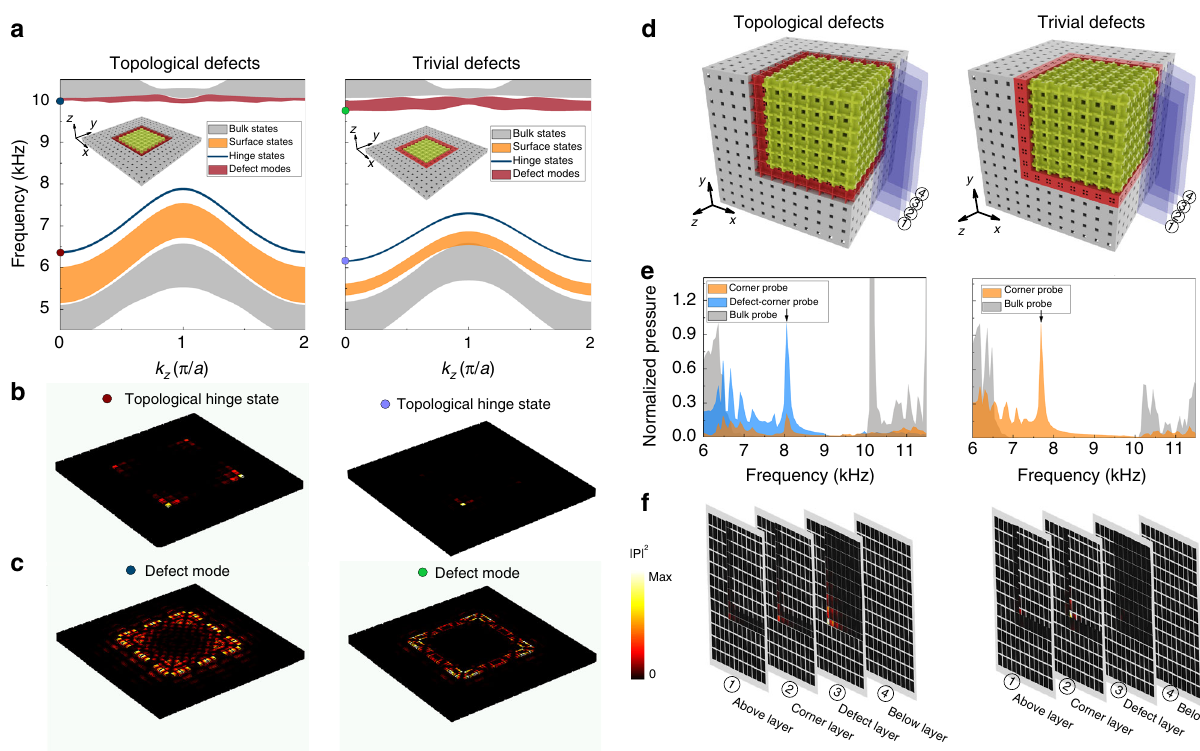
Fig. 6 Topological hinge and corner states with the existence of symmetry-preserving defects. Two types of defects as that in Fig. 5 are studied. a – c The same as that presented in Fig. 5, but for the hinge supercell consisting of a topological SC with 7 ´ 7 unit cells, surrounded by a wall of trivial SC with four unit cells. The defect layer is inserted at the interfaces between the topological and trivial SCs (see the insets in a for the detailed structures). It is observed from the fi gures that the symmetry-preserving defects do not considerably affect the topological hinge states, which emerge and remain in the gaps of the surface and bulk states. d Structures with a defect layer made of topological or trivial SC and inserted on the interfaces of the corner supercell. e Numerically calculated transmission spectra for both the corner and bulk probes under a point source excitation (near the concerned corner). Transmission peaks corresponding to the corner modes are observed around 8.04 kHz for the case with the topological defect layer (left panel) and around 7.68 kHz for the case with the trivial defect layer (right panel). f Acoustic pressure pro fi les of the excited corner states (whose frequencies are indicated by the black arrows in e ). The slice positions for the plots in f are illustrated in d